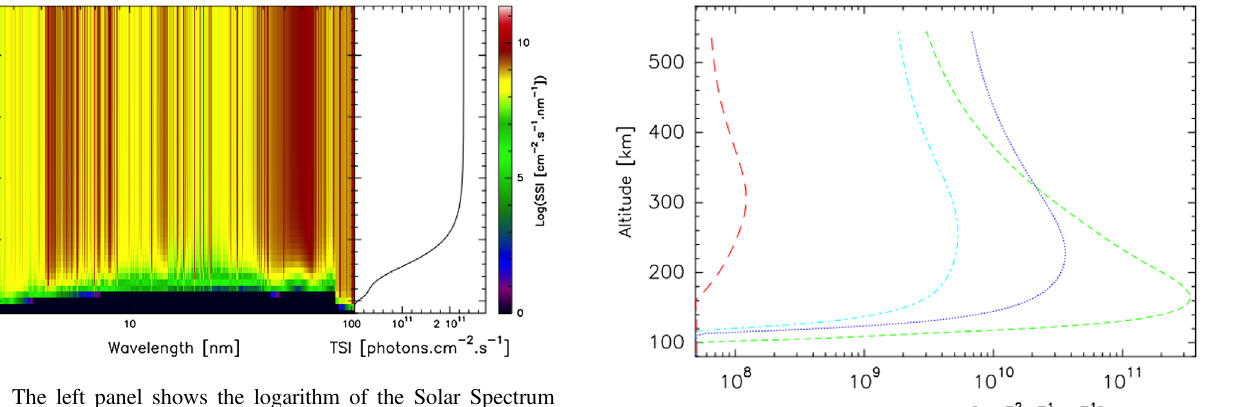
Fig. 2. The left panel shows the logarithm of the Solar Spectrum Irradiance, or SSI (cm (cid:3) 2 s (cid:3) 1 nm (cid:3) 1 ) as a function of the wavelength (nm) and the altitude. The color code lies in the right of the fi gure. The right panel is the integration over all wavelengths (Total Solar Irradiance, or TSI).